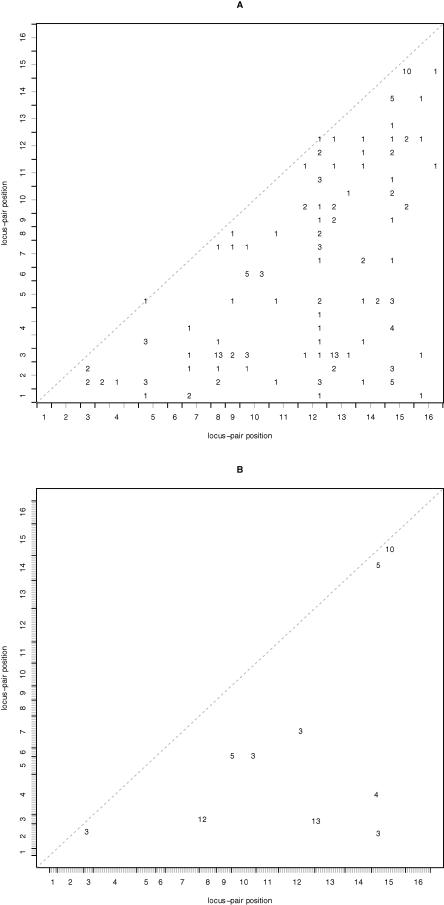
A Plot of the Locus Pair Positions Corresponding to the 170 Traits Significant for Joint Linkage(A) A plot of the significant locus pair positions when each chromosome has been partitioned into equally sized bins less than or equal to 550 kb. The number of significant traits showing linkage to locus pairs in each pair-wise bin is denoted. The number on each axis indicates the chromosome number; a dash denotes a bin division.(B) A plot constructed analogously to (A), except bins less than or equal to 50 kb are used, and only bins with three or more traits significant for joint linkage are numbered.